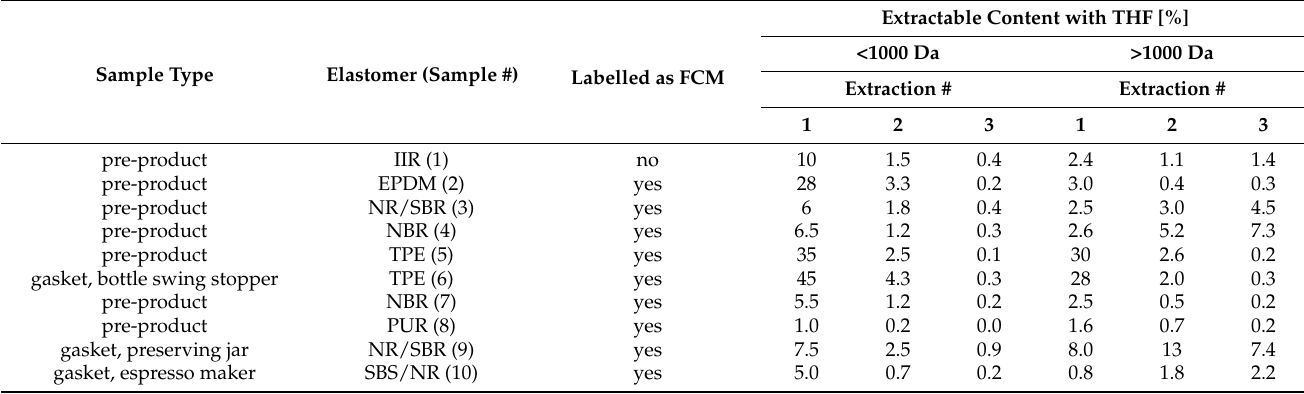
Table 1. Extraction in percent of elastomer weight for three consecutive